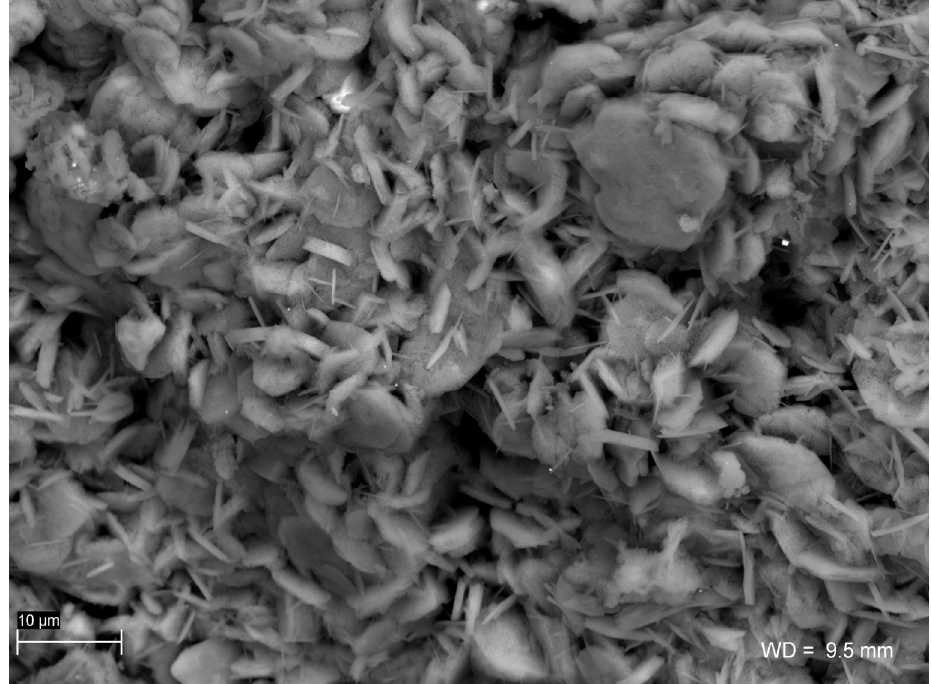
Figure 5. SEM image of platy microcrystals of steklite from Rydu ł